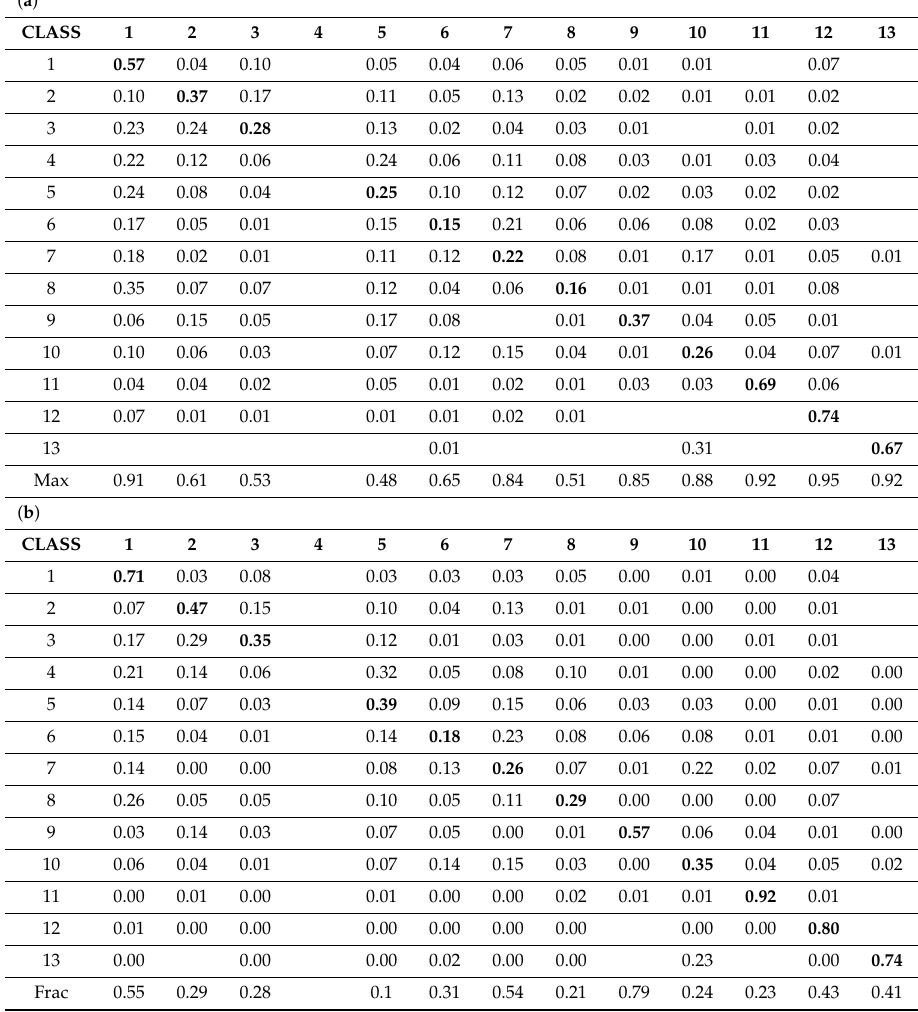
Table 8. ( a ) The mean sub-fractional error matrix for CCI (rows) relative to NALCMS (columns) based on the 13-class common legend across 18 ecozones over Canada. Value of zero is omitted. Please note that there is no mosaic class in NALCMS. The 13LC classes are: 1-NF, 2-BF, 3-MF, 4-Mosaic,